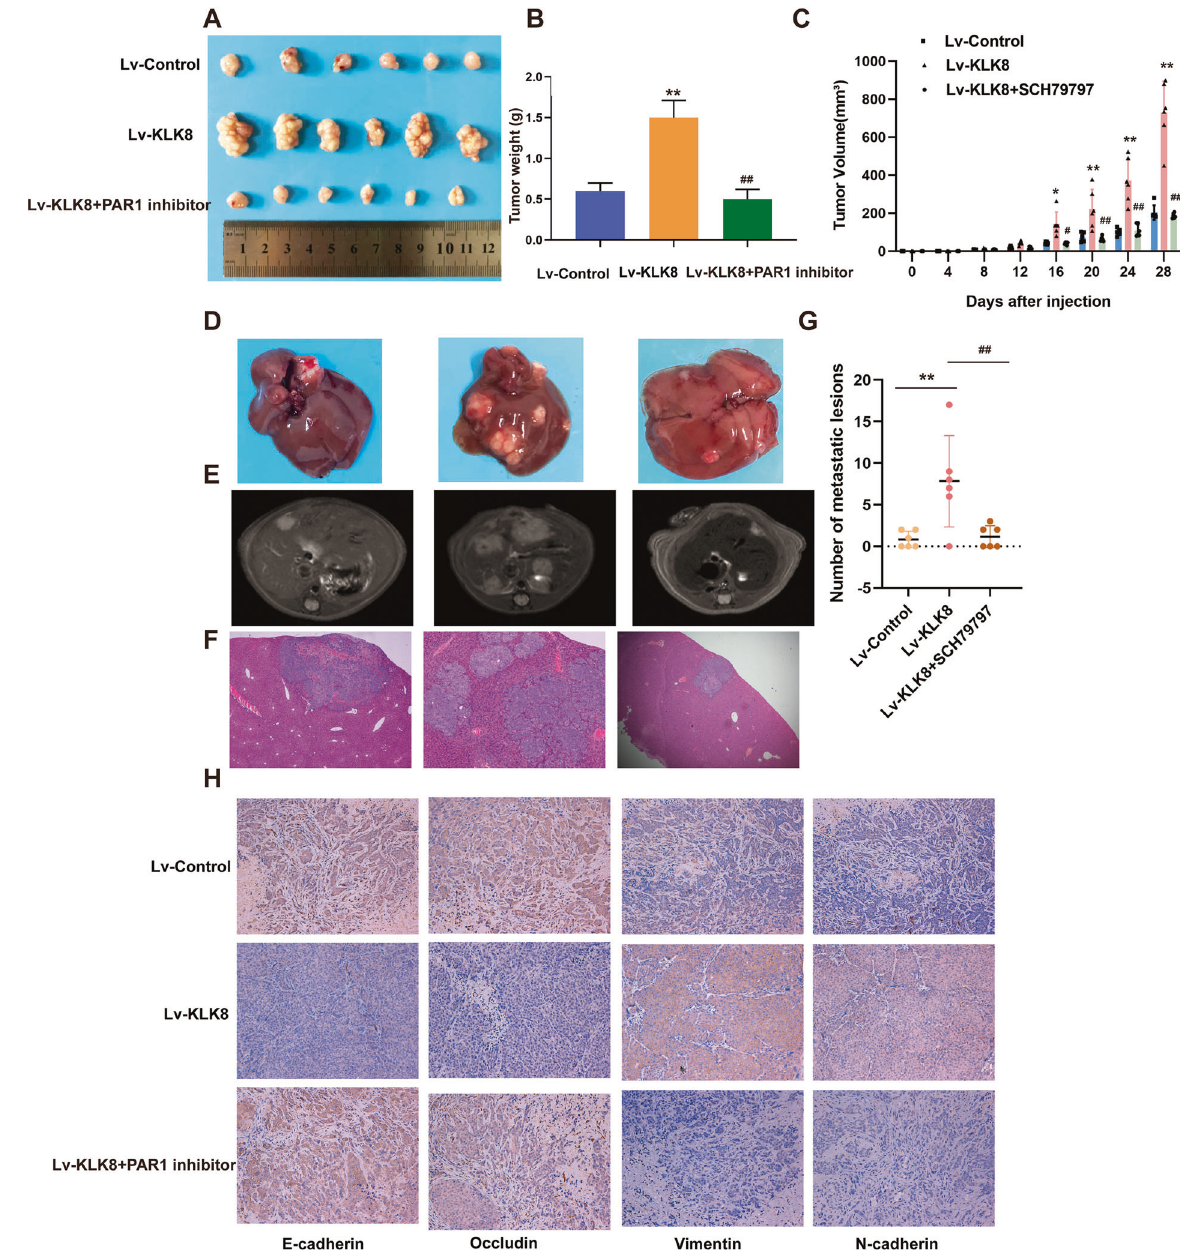
Fig. 9 PAR1 inhibition suppresses proliferation and metastasis in colorectal cancer cells induced by KLK8 in vivo. A Photographs of tumours excised from mice injected with normal cells or cells with modi fi ed KLK8 expression ( n = 6 per group). After 28 days, the mice were sacri fi ced, and the tumours were weighed ( B ). C KLK8-overexpressing cells produced larger tumour masses than control cells. D Representative images of livers after injection of modi fi ed RKO cells into the spleen. The metastatic nodules in the Lv-KLK8 group is clearly shown. E Representative images of PET CT and H&E staining ( F ) of metastatic nodules in the livers, ×100. G The numbers of metastatic nodules in the livers. H Immunohistochemical staining for E-cadherin, N-cadherin, vimentin and occludin expression in harvested mouse tumour samples, ×200. The statistical analyses are shown ( n = 6). * P < 0.05, ** P < 0.01 vs. Lv-control; # P < 0.05, ## P < 0.01 vs.